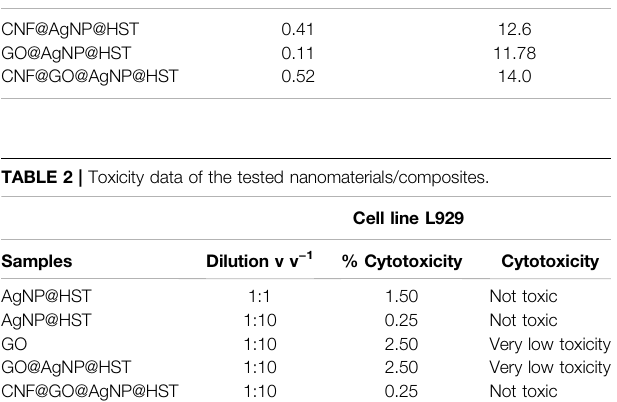
TABLE 1 | Mechanical performance of the tested nanomaterials/composites. Samples